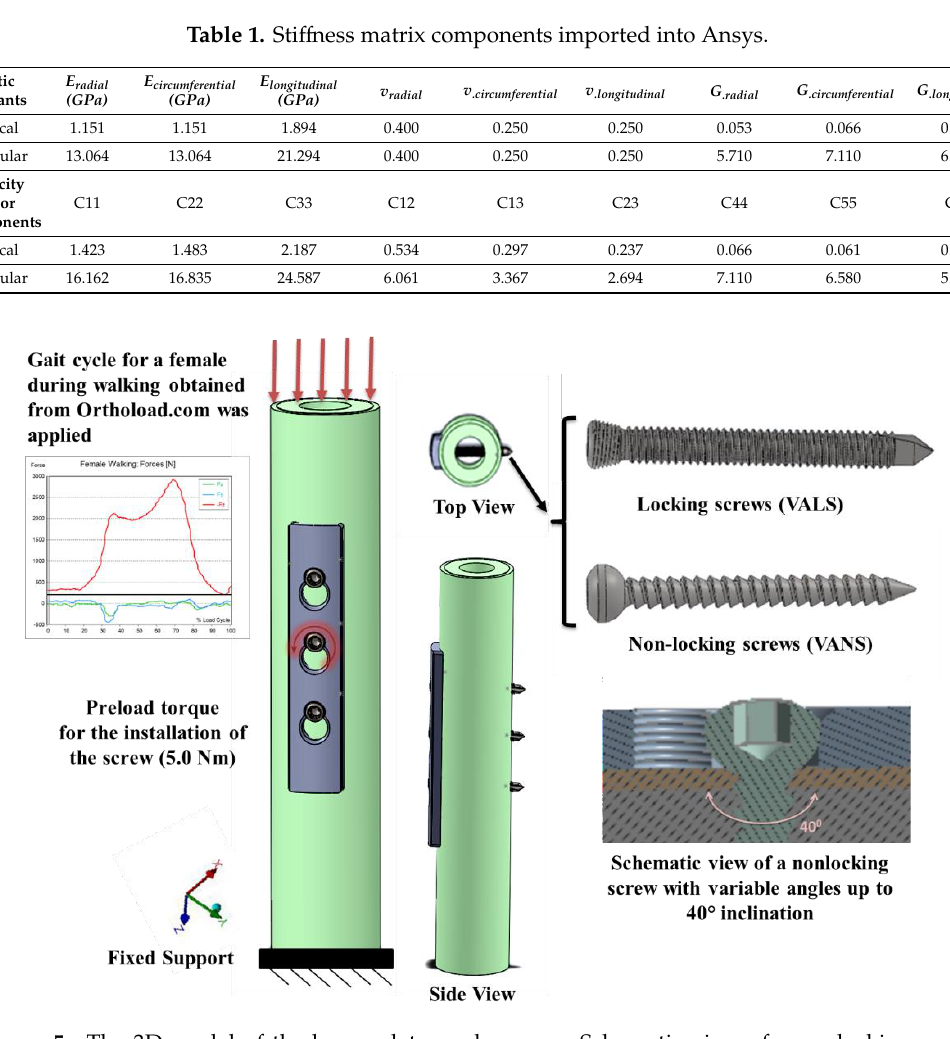
Table 1. Stiffness matrix components imported into Ansys.